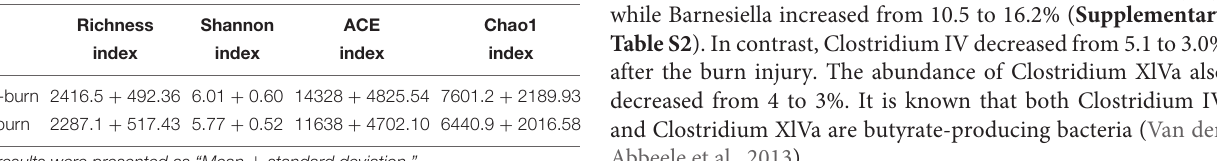
Frontiers in Microbiology |